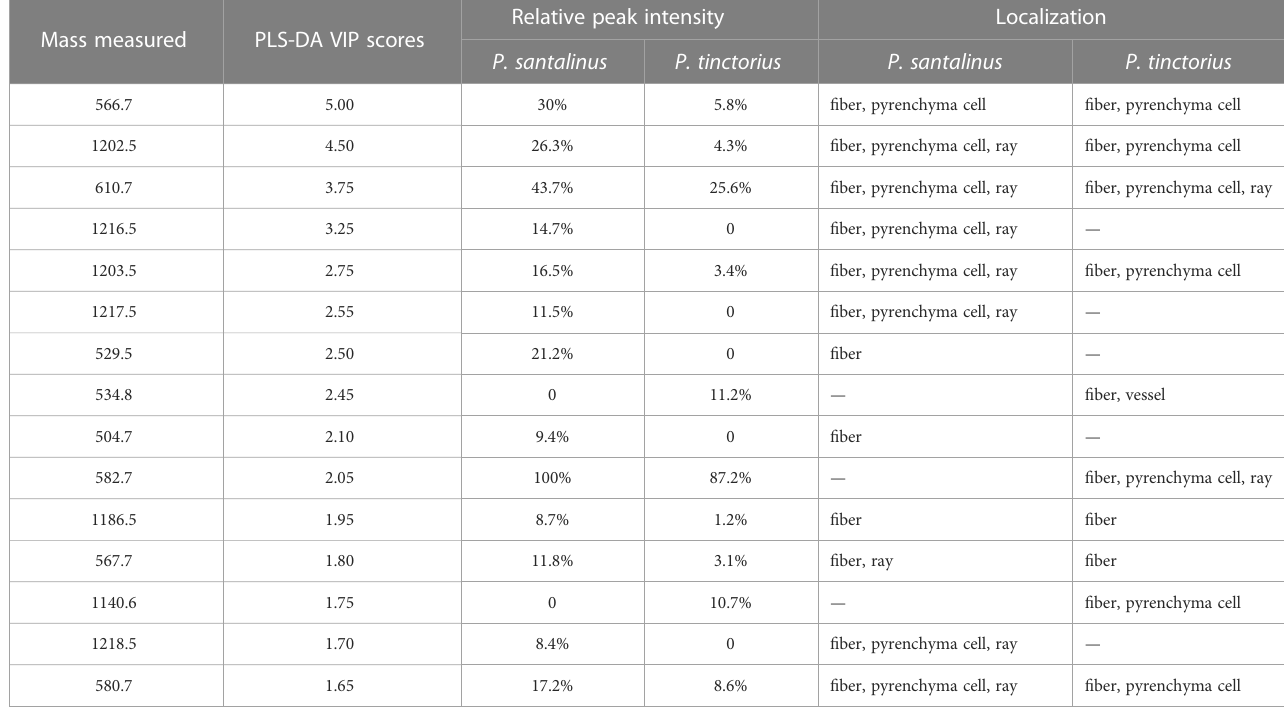
TABLE 1 Potential chemical markers for the interspeci fi c differentiation of P. santalinus and P. tinctorius . Relative peak Mass measured PLS-DA VIP scores